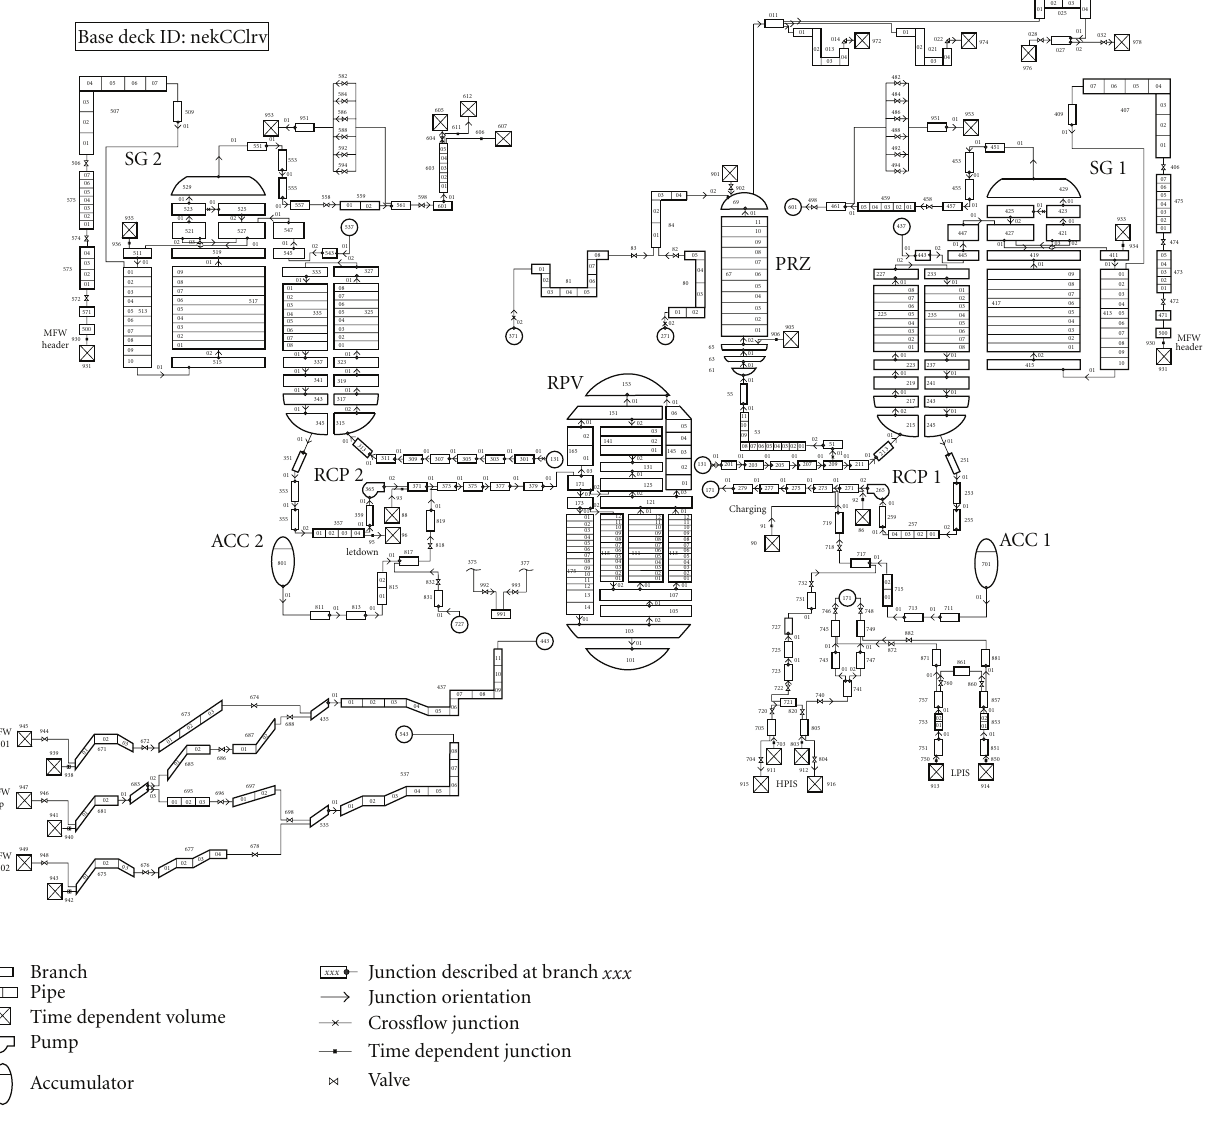
Figure 1: NEK RELAP5/Mod3.3 nodalization scheme.